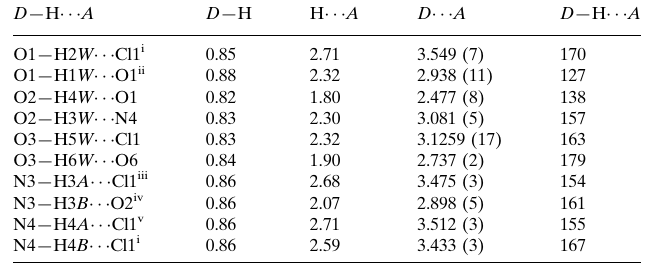
Hydrogen-bond geometry (A˚ , (cid:3)